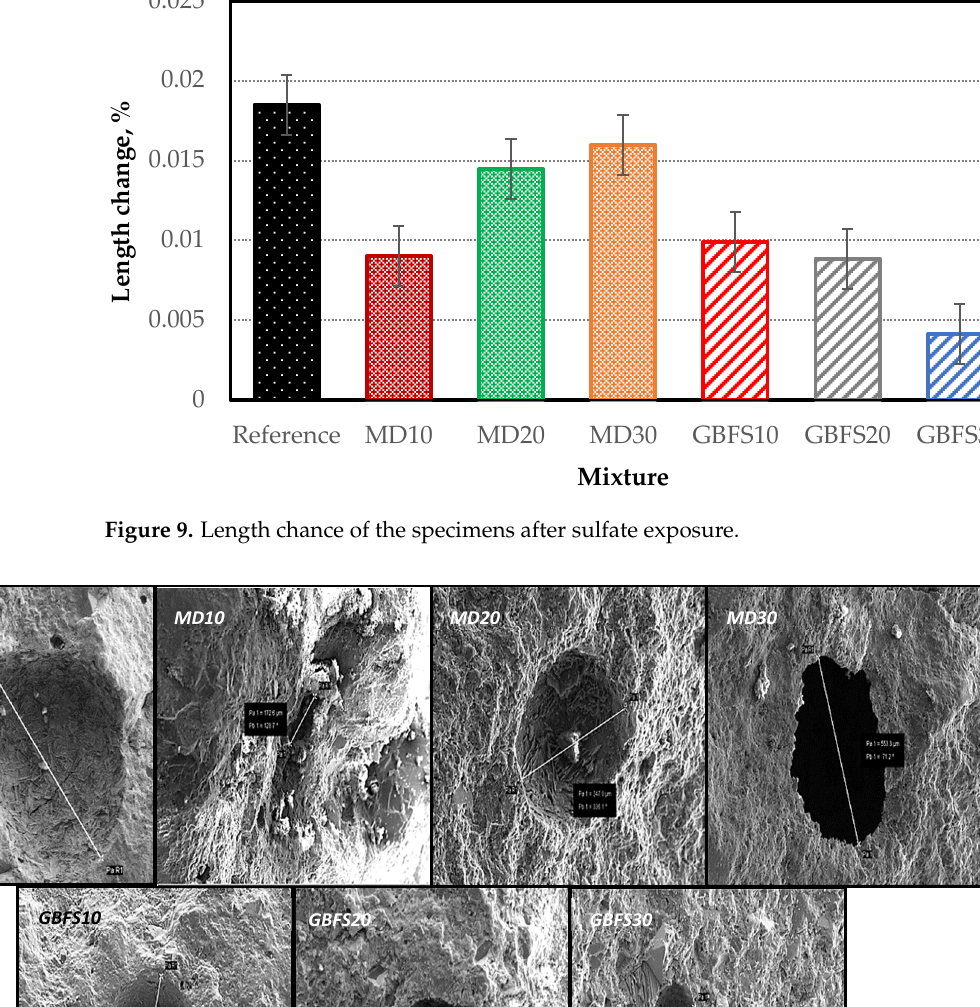
Figure 9. Length chance of the specimens after sulfate exposure.